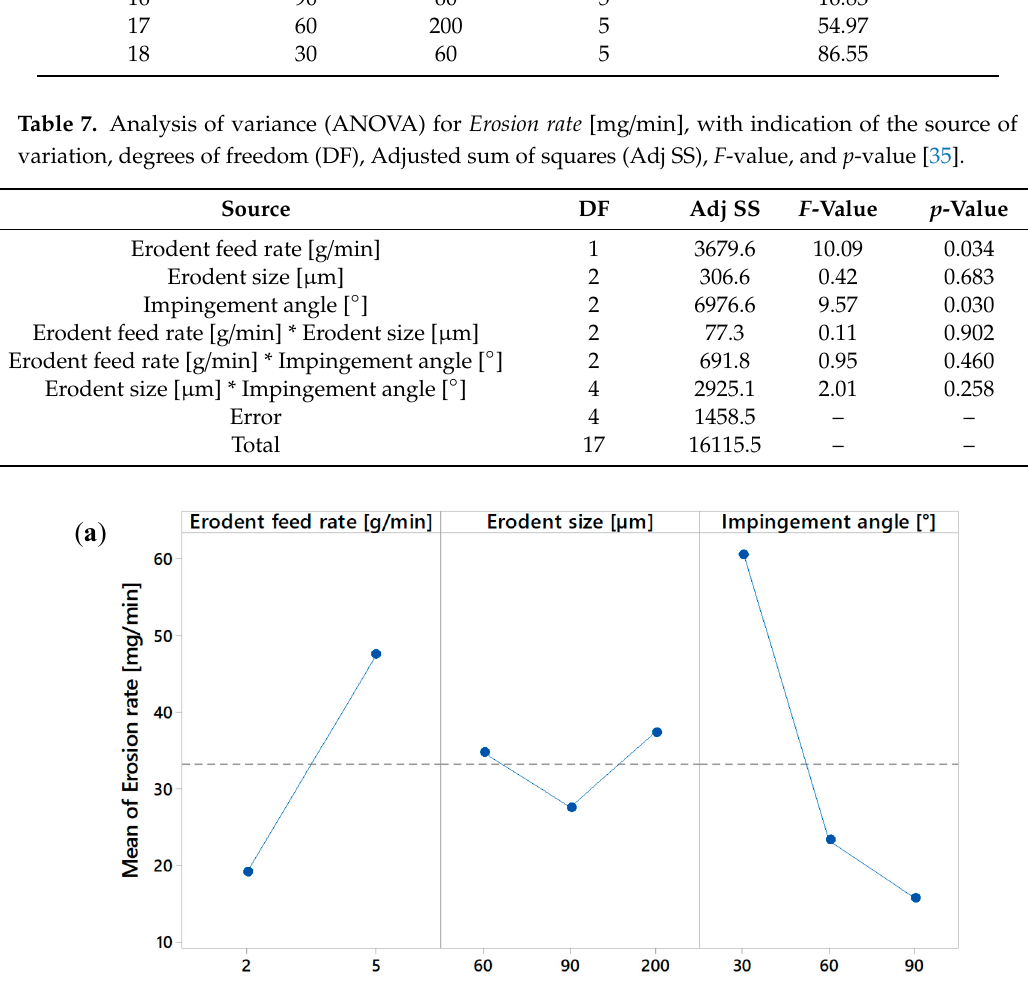
Table 6. Arrangement of the general full factorial design (GFFD) for the three independent variables and experimental values of the Erosion rate.